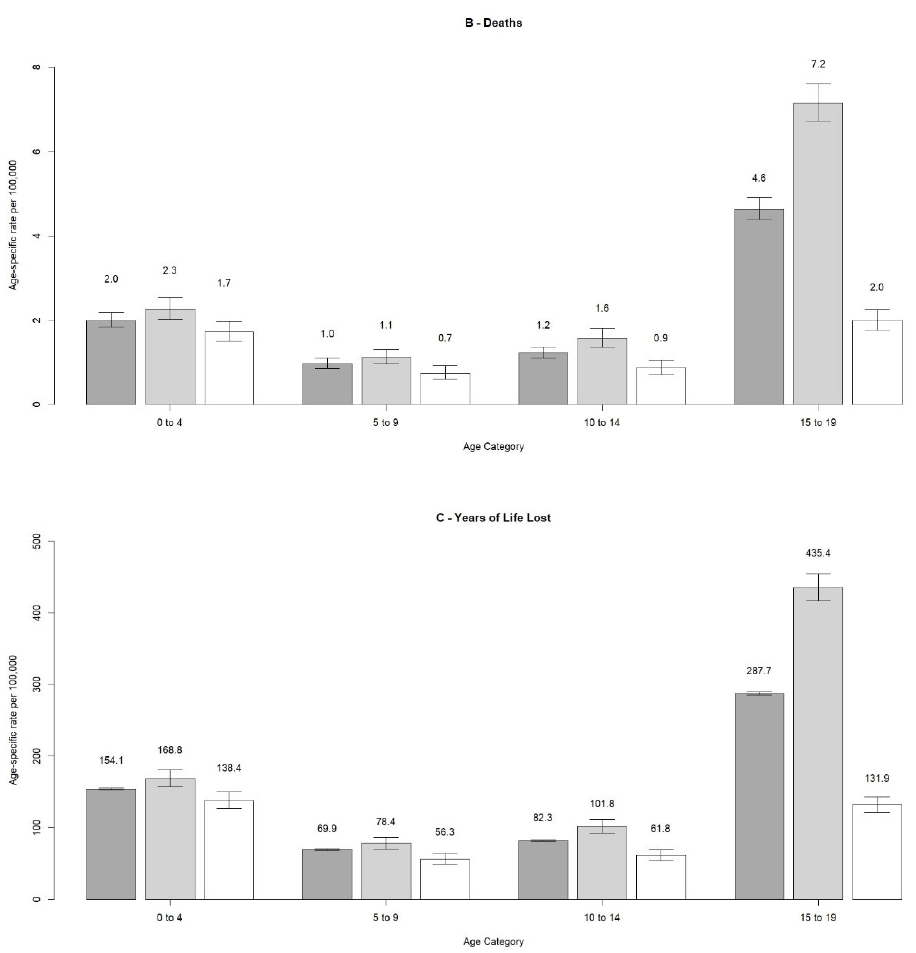
Figure 2. Age ‐ standardized rates of TBI ‐ related hospital discharges ( A ), deaths ( B ) and YLLs ( C ) Figure 2. Age-standardized rates of TBI-related hospital discharges ( A ), deaths ( B ) and YLLs ( C ) with estimated pooled rates for the analyzed 30 European countries in 2014. with estimated pooled rates for the analyzed 30 European countries in